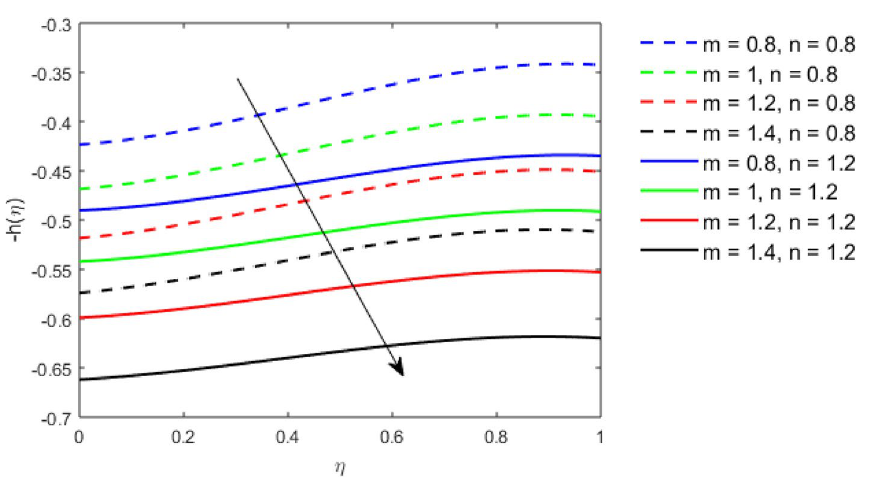
Figure 8. The Axial velocity profile for increasing thickness index m of disk for Pseudoplastic and dilatant